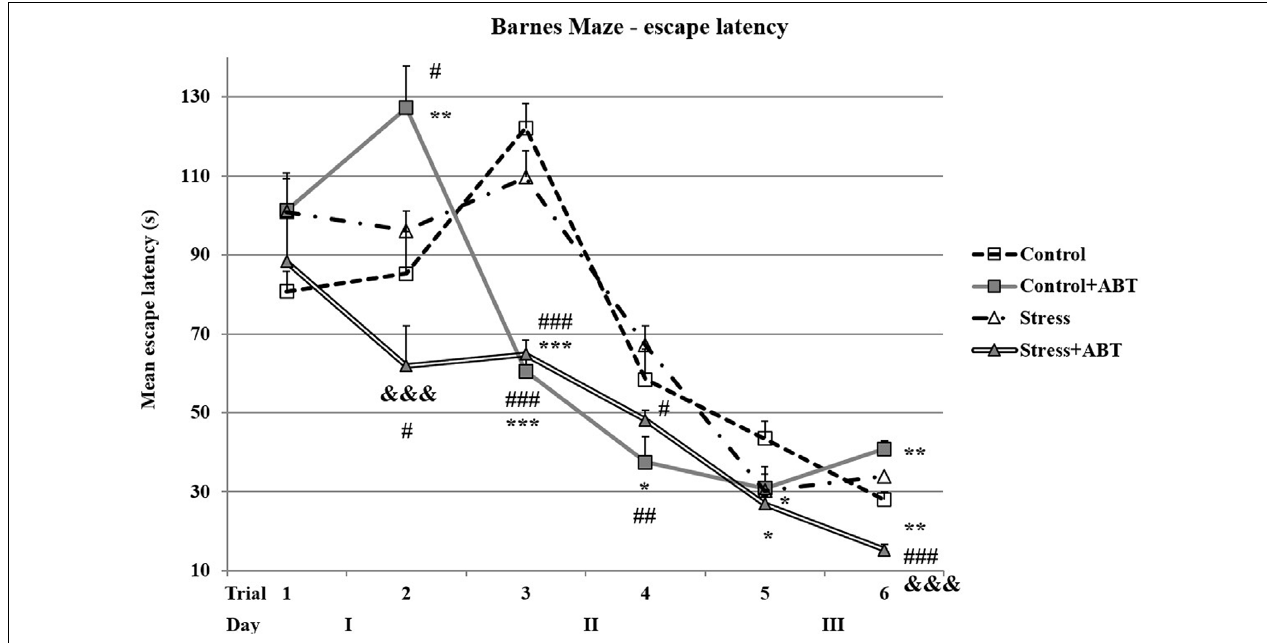
FIGURE 5 | Effects of chronic stress, prolonged ABT-239 pre-treatment on performance in spatial memory test of the BM task. Each point of the graph represents the mean escape latency ± SEM obtained from eight to nine rats (two trials per day). In the first trial, no significantly different results were found. In the second trial, Control rats were significantly different in comparison with Control + ABT ( ## p < 0.01) and stressed with: # p < 0.05 vs. Control + ABT; # p < 0.05 vs. Stress + ABT. Statistically significant differences were also in Stress + ABT vs. Control + ABT ( &&& p < 0.001). In the third trial, Control rats were significantly different in comparison with Control + ABT (*** p < 0.001) and with Stress + ABT (*** p < 0.001). Statistically significant differences were also found in stressed rats with Stress + ABT ( ### p < 0.001) and with Control + ABT ( ### p < 0.001). In the fourth trial, Control rats were significantly different in comparison with Control + ABT (* p < 0.05) and Stressed rats in comparison with Stress + ABT ( # p < 0.05) as well as with Control + ABT ( ## p < 0.01). In the fifth trial, the differences were statistically significant in Control rats in comparison with Stress (* p < 0.05) and Stress + ABT (* p < 0.05). In the sixth trial, statistically significant differences were noted in Control vs. Control + ABT (** p < 0.01), Control vs. Stress + ABT (** p < 0.01); Control + ABT vs. Stress + ABT ( &&& p < 0.001), Stress + ABT ( ### p < 0.001)